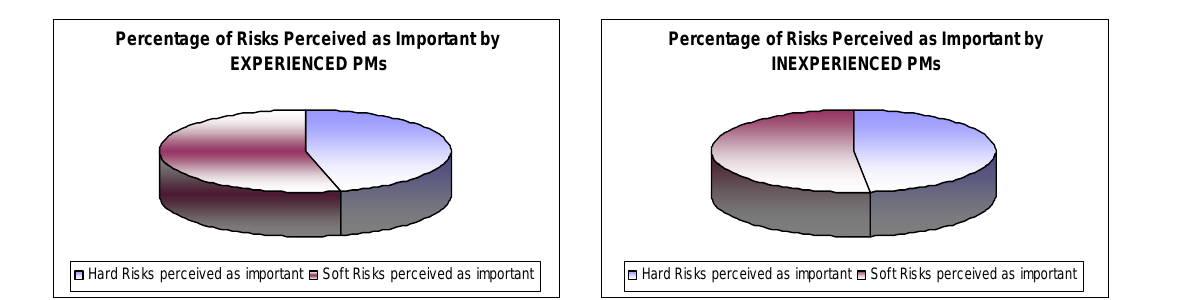
Figure 9: Percentage of hard and soft risks Figure 10: Percentage of hard and soft risks perceived as important by inexperienced